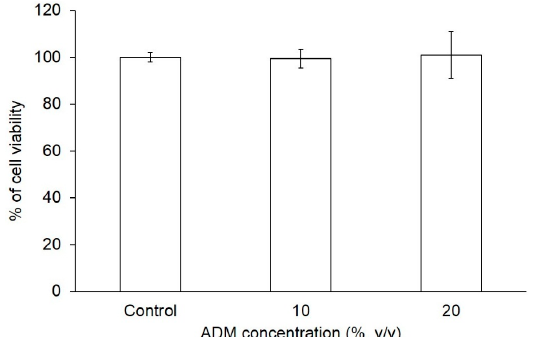
Figure 1. The effect of ADM concentration on cell viability. Human dermal fibroblasts, Hs68 were incubated with ADM for seven days. Data are expressed by the mean of percent cell viability compared to control ± standard deviation, n = 3.